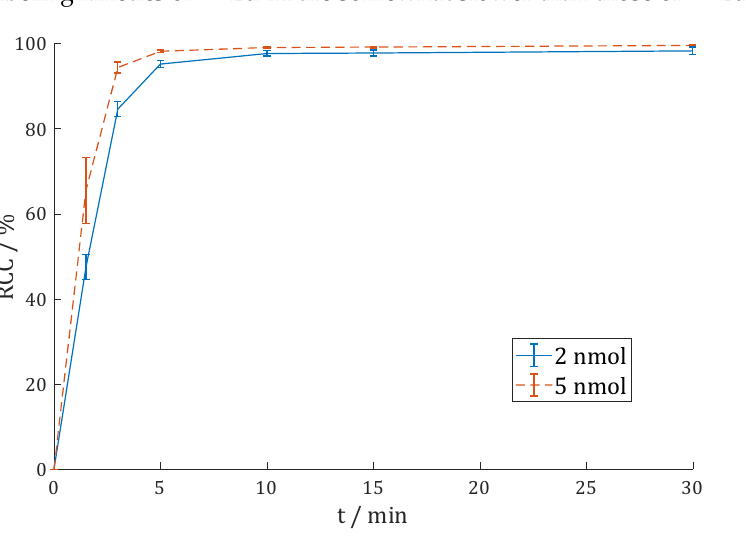
Figure 7. Reaction kinetics (radiochemical conversion (RCC) in %) of [ 177 Lu]Lu ‐ DO3A.Glu.(FAPi) 2 177 Lu ‐ 11 in 1 M HEPES (pH = 5.5) at 95 °C with 50–100 MBq 177 Lu (n = 5). Whereas the RCC is > 99% after 1.5 min for 2 nmol 13 , it takes 5 min to reach > 95% with 177 Lu ‐ 11 , and even 5 min to obtain RCC > 98% with 5 nmol 177 Lu ‐ 11 . Nevertheless, 177 Lu ‐ 11 can be synthesized in practically quantitative RCCs (> 98% with 2 nmol for 30 min; > 99% with 5 nmol for 10 min). The second TLC system and radio ‐ HPLC (cf. Figure S16) also gave almost quantitative RCC/RCP.